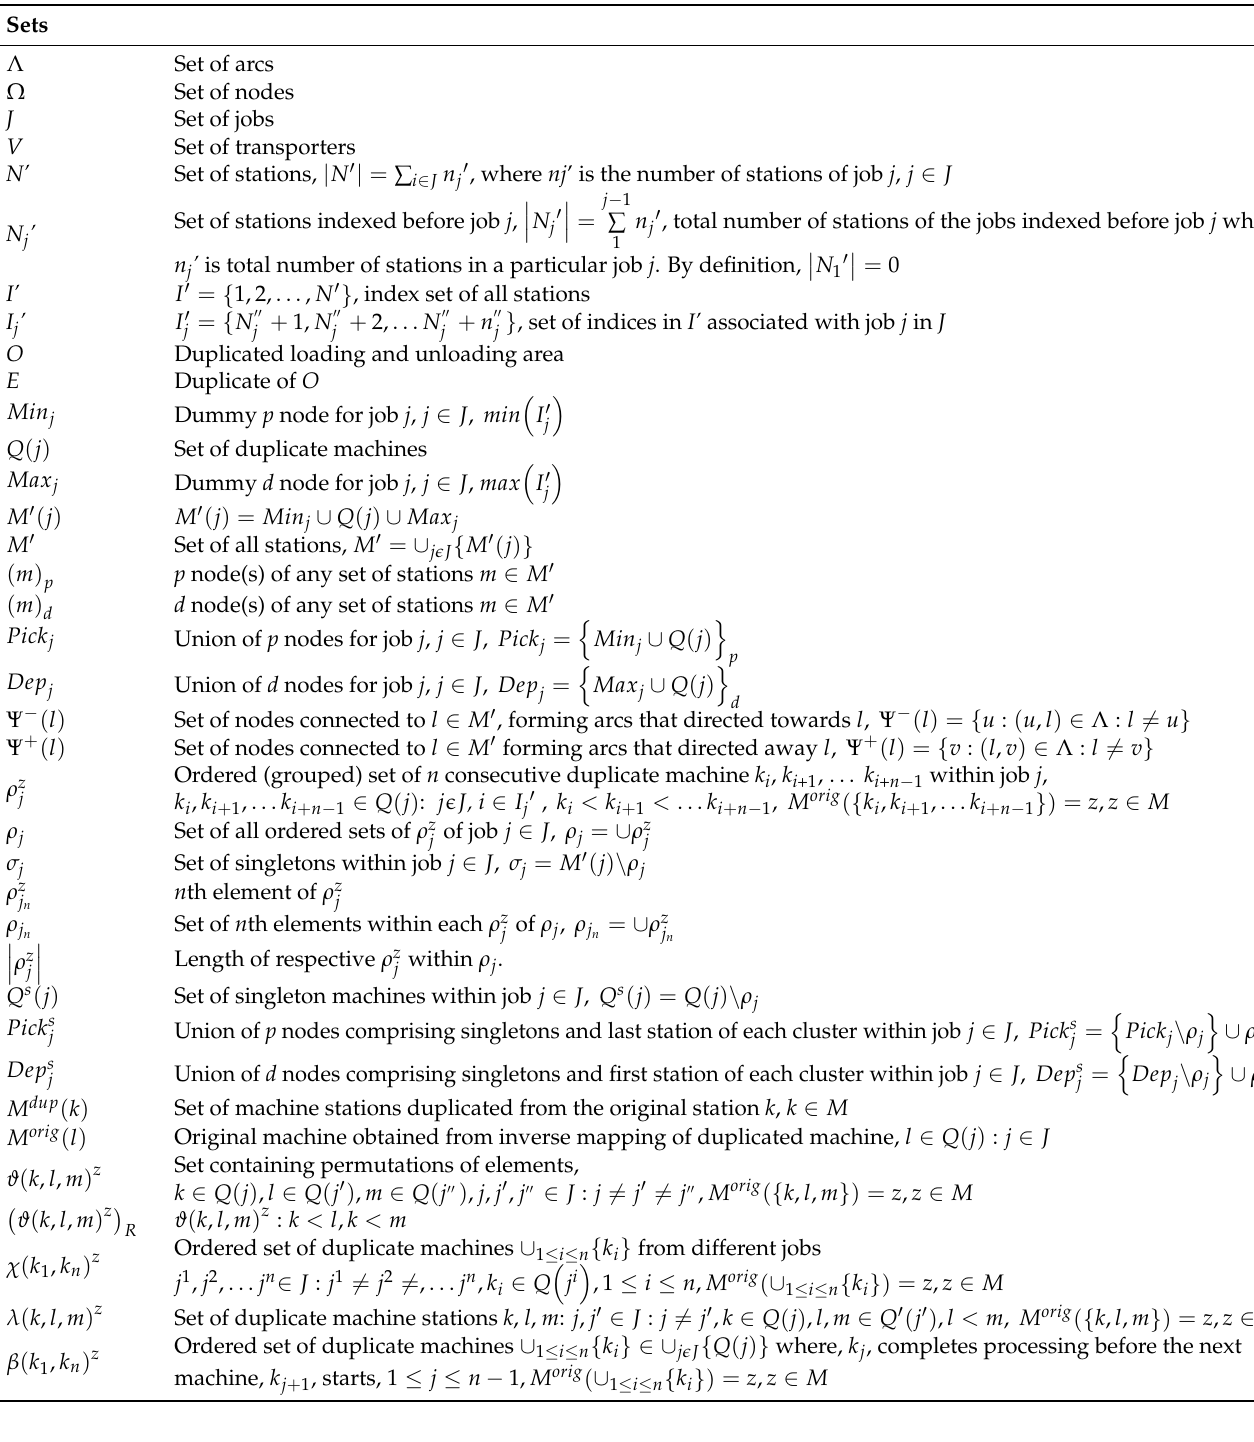
Table 2. Notation used by